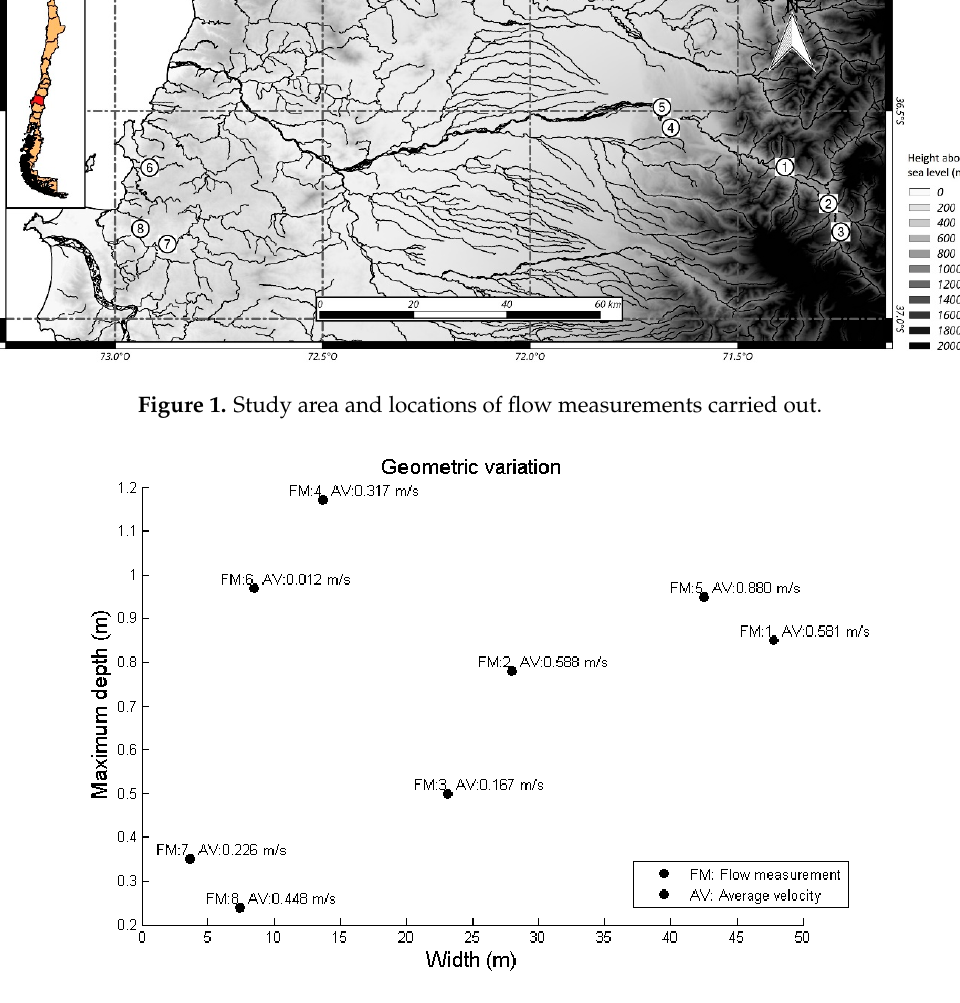
Figure 2. Geometric and flow characterization of the gauged sections.